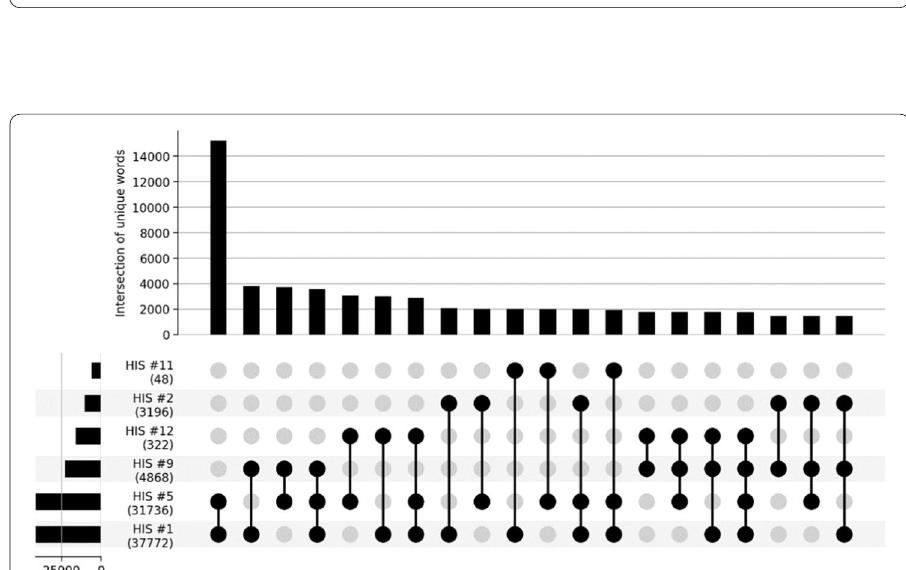
Fig. 6 Comparison of HIS corpora for text length ( a ), number of words in texts ( b ), and number of sentences in texts ( c ). HISs are sorted by the number of records